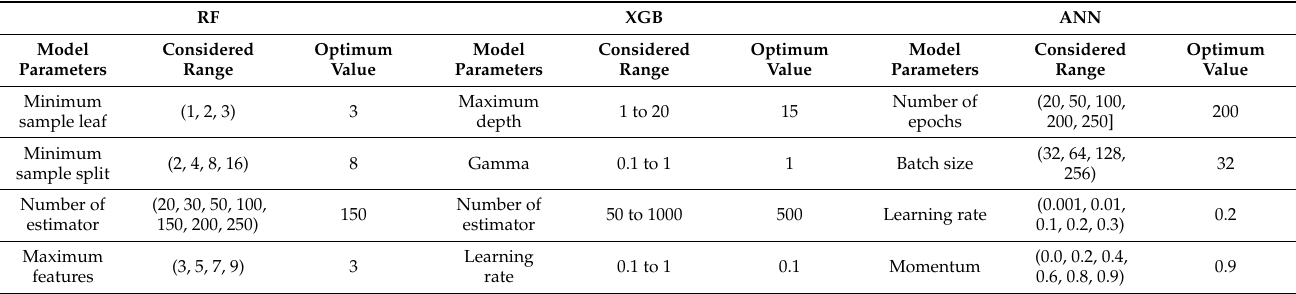
Table 4. Parameter selection through grid